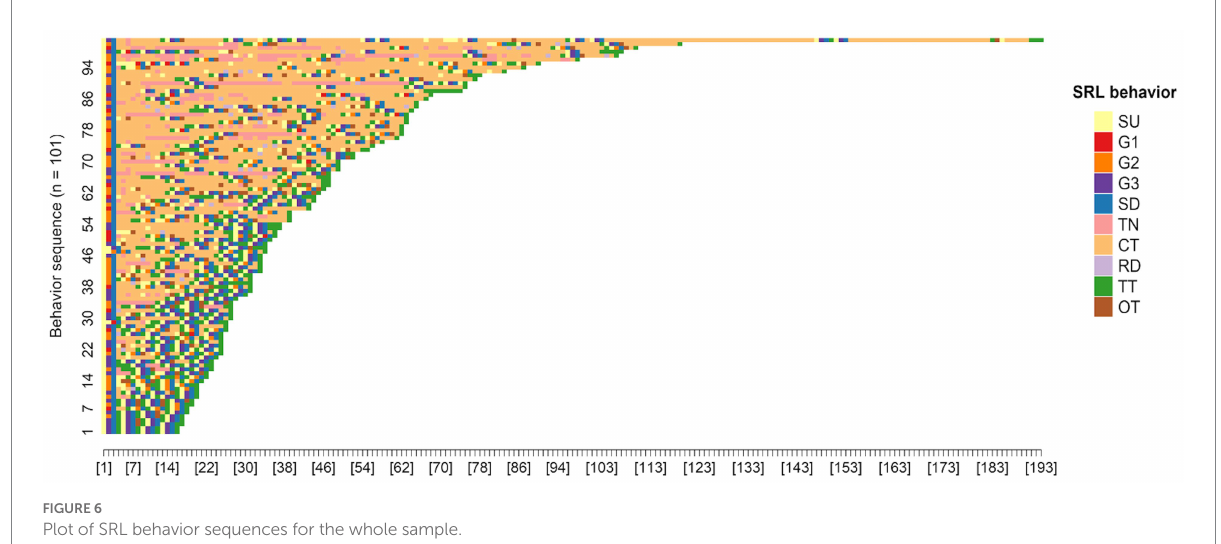
FIGURE 6 Plot of SRL behavior sequences for the whole